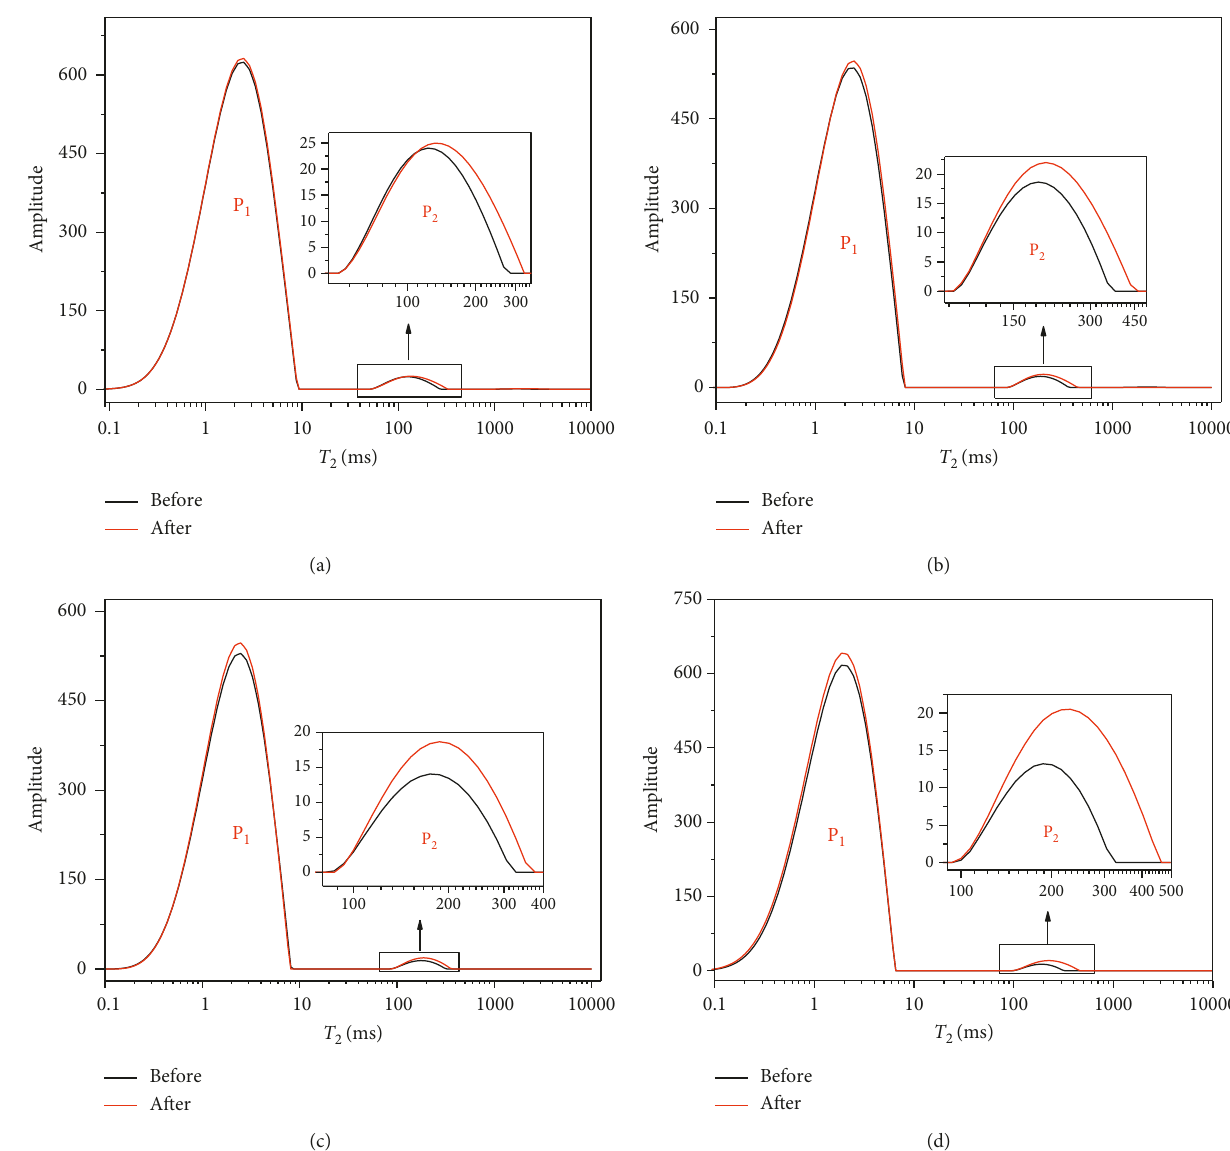
Figure 3: Contrast of T 2 distribution curve before and after the freeze-thaw action of liquid nitrogen. (a) Water saturation 0%. (b) Water saturation 34.2%. (c) Water saturation 67.8%. (d) Water saturation